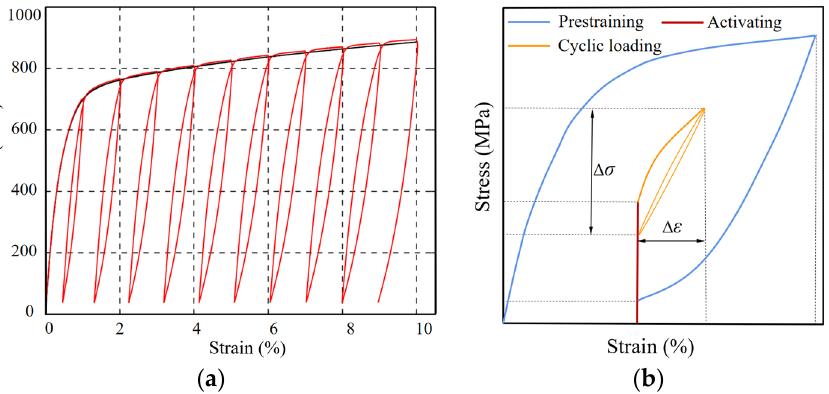
Figure 6. Loading curves of Fe-SMA [83]: ( a ) under pseudo-static load, ( b ) under fatigue load after activation.